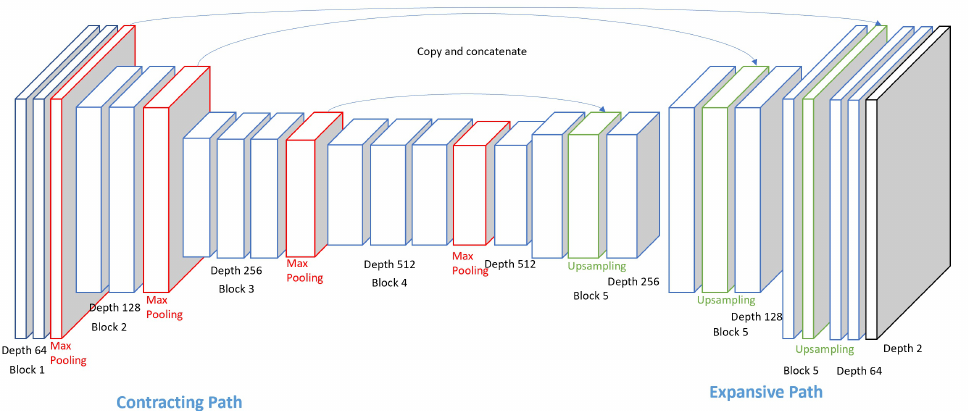
Figure 2. The VGG-UNet